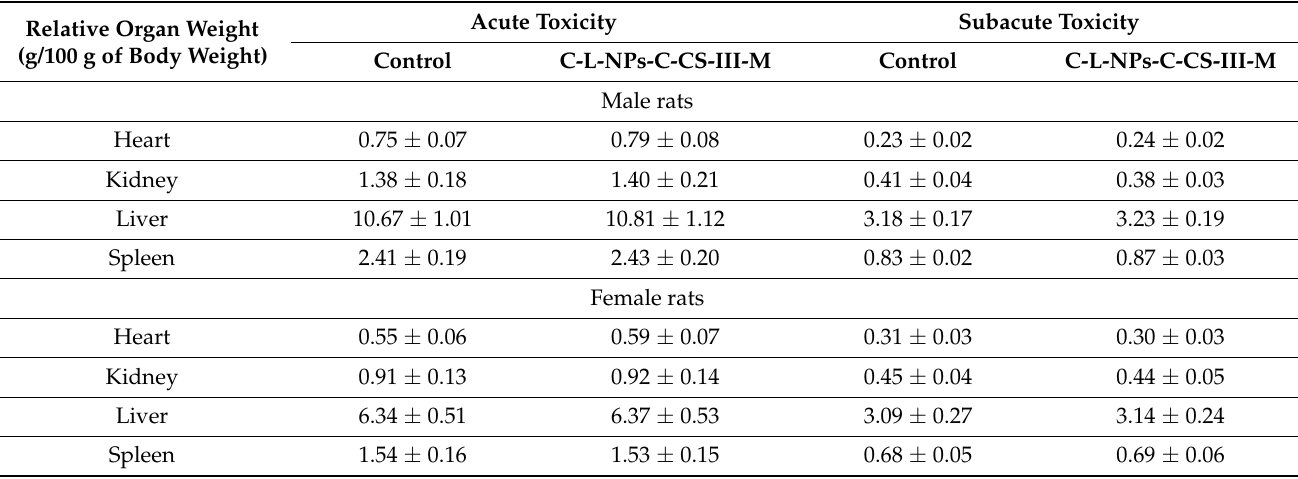
Table 14. Relative organ weights of rats following oral administration of C-L-NPs-C-CS-III-M . Relative Organ Weight (g/100 g of Body